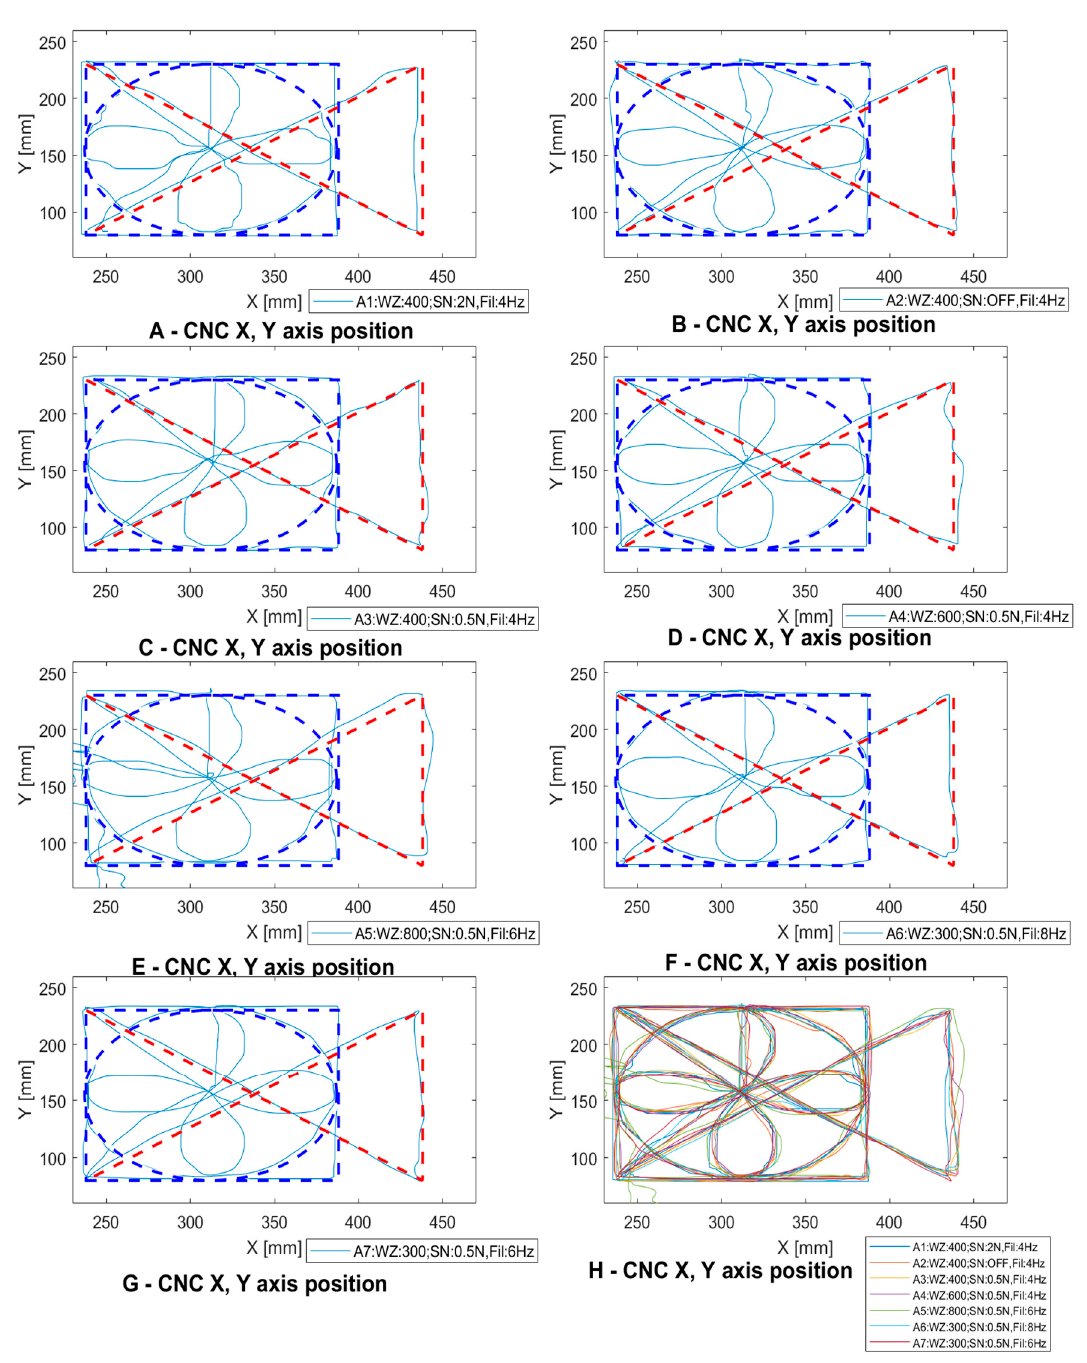
Figure 11. System calibration for second operator.